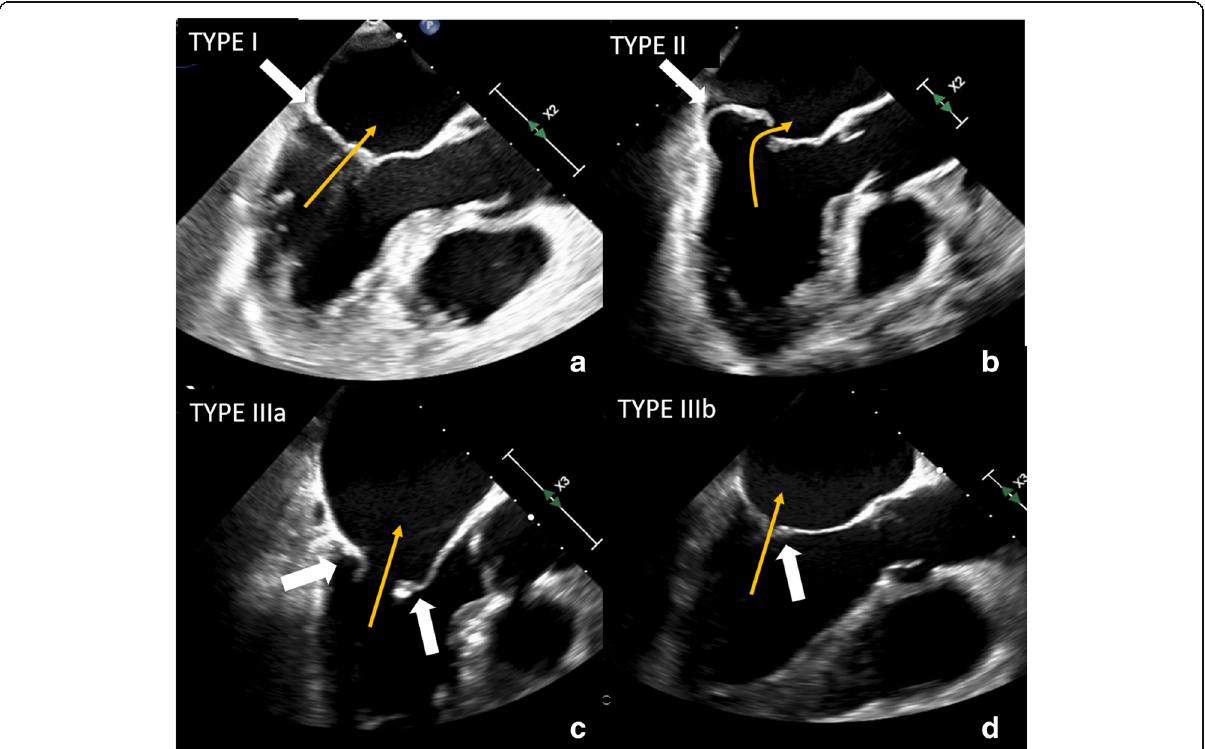
Fig. 3 Transesophageal echocardiographic (TOE) images of mitral regurgitation (MR) according to the Carpentier classification. The MR flow direction is represented by an orange arrow. ( a ) An example of Carpentier type I: long-axis midesophageal (ME) view TOE showing normal valve anatomy with no prolapse or tethering but atrial dilatation/dysfunction (atrial MR) with horizontal coaptation of the leaflet (white arrow). ( b ) An example of Carpentier type II: prolapse of posterior leaflet (white arrow) in a valve with myxomatous degeneration (Barlow ’ s disease). ( c ) Carpentier type IIIa. Long-axis ME view TOE showing diastolic movement restriction (white arrows) in a valve affected by rheumatic disease. Of note, leaflet thickening and retraction with “ hockey stick ” morphology of anterior leaflet (white arrow on the right side). ( d ) Carpentier type IIIb. Long-axis ME view TOE showing systolic movement restriction in a patient with previous anterior myocardial infarction. Of note, the coaptation gap between mitral valve leaflets (white